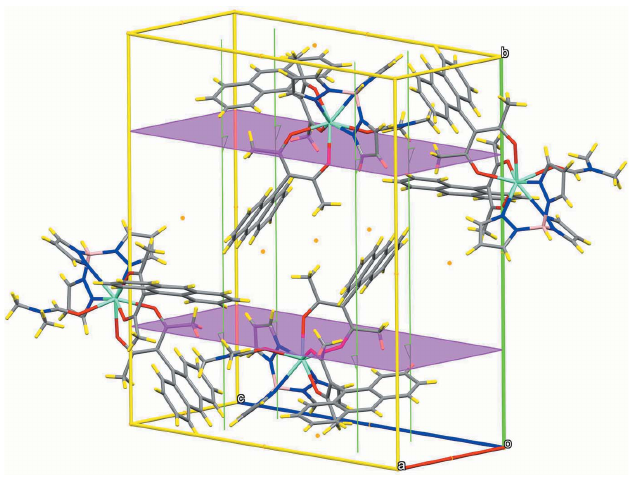
Figure 2 Stick diagram of a unit-cell view with symmetry elements: inversion centers (orange), glide planes (violet) and screw axes (green).